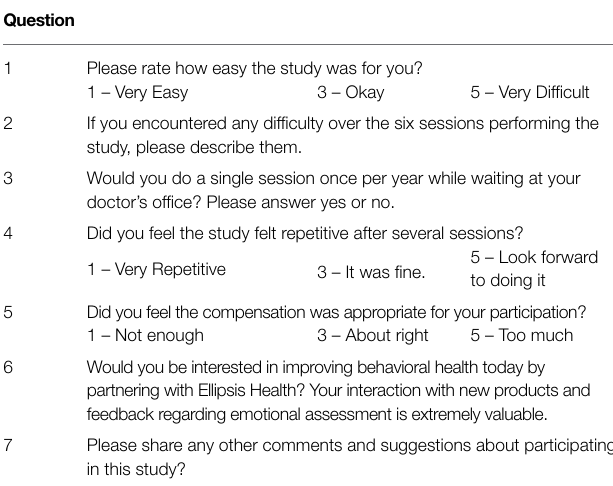
Table 6 . Correlations between most demographics versus initial PHQ-8 and initial GAD-7 scores were not statistically significant.